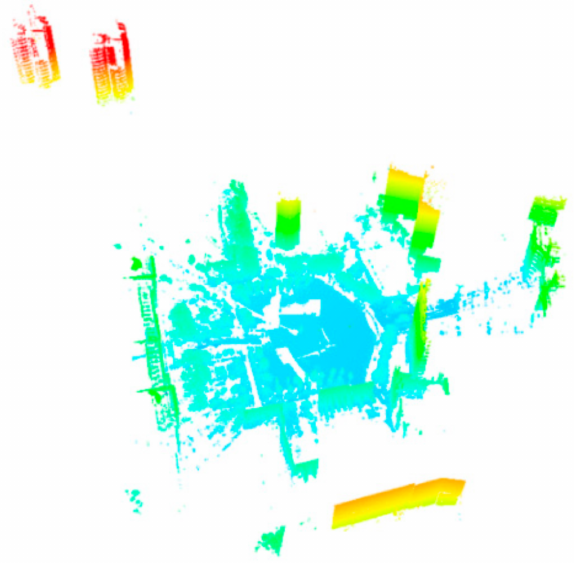
Figure 8. The first data set rendered by